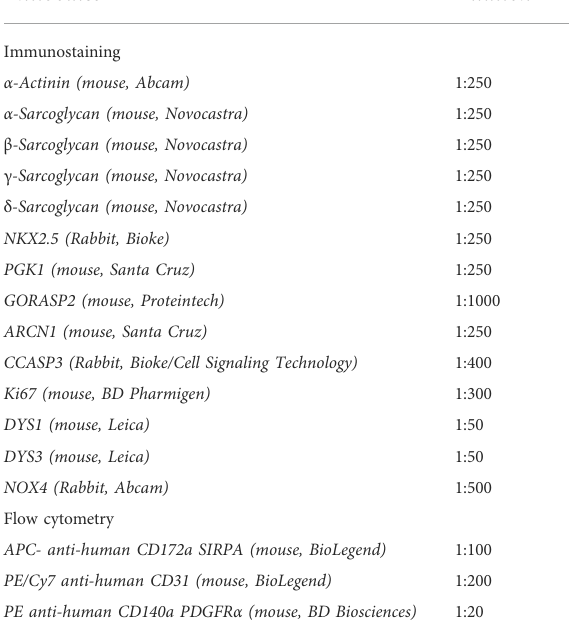
TABLE 2 List of antibodies dilutions used for immuno fl uorescence analysis and fl ow cytometric analysis. Antibodies